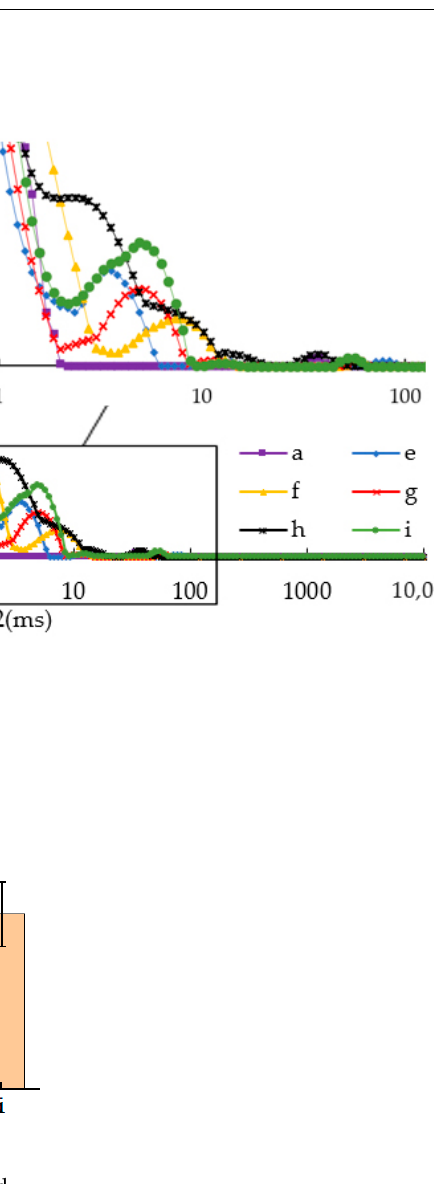
Figure 7. The NPA of CRM asphalt binders unaged.